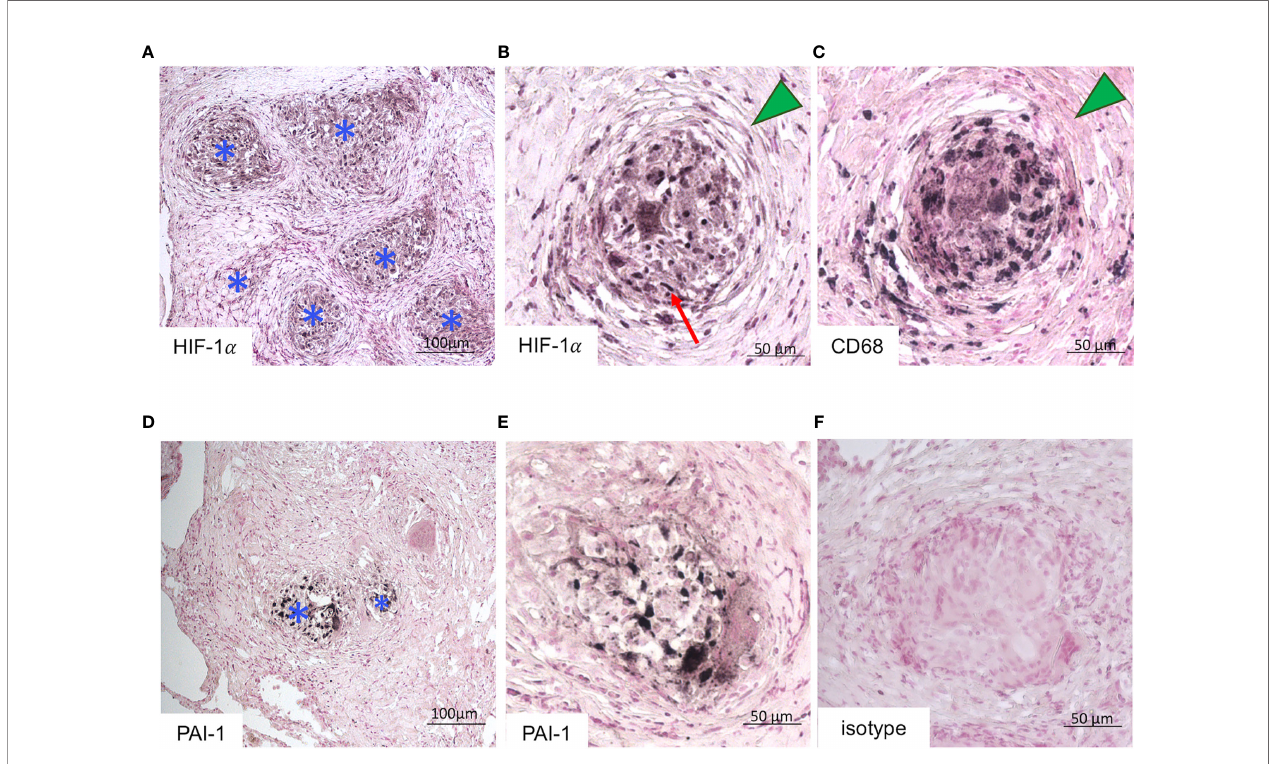
FIGURE 7 | Detection of HIF-1 a and PAI-1 in granulomas from pulmonary biopsies. (A, B) HIF-1 a , (C) CD68 and (D, E) PAI-1 expression assayed by immunohistochemistry in archived lung biopsy from sarcoidosis patient. (A – F) are representative of the results obtained in lung biopsies from three sarcoidosis. (A, D) Granulomas are identi fi ed by a blue asterisks. (B, C) Serial sections of a granuloma wrapped with lamellar fi brosis (green triangle) showing HIF-1 a expression in epithelioid cells characterized by their large cytoplasm, eccentric reniform nuclei (red arrow) (B) and CD68+ labelling (C). ( A, D magni fi cation x100 B, C, E, F magni fi cation x200). Isotype control is shown in (F)